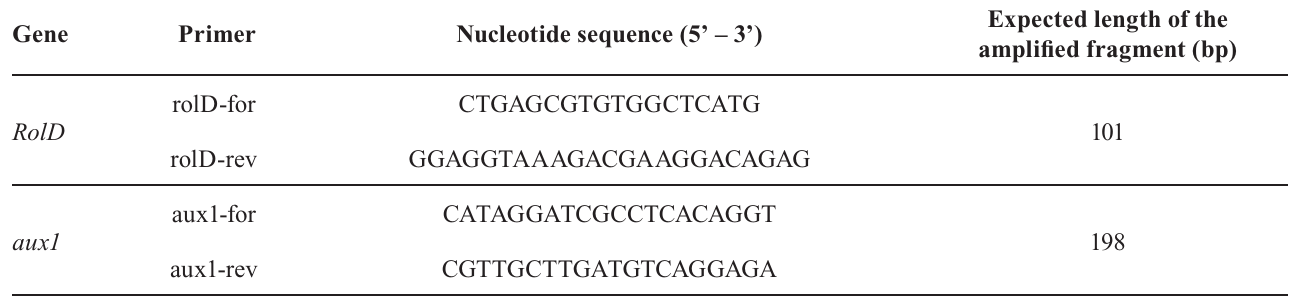
TABLE I - N ucleotide sequences of PCR primers